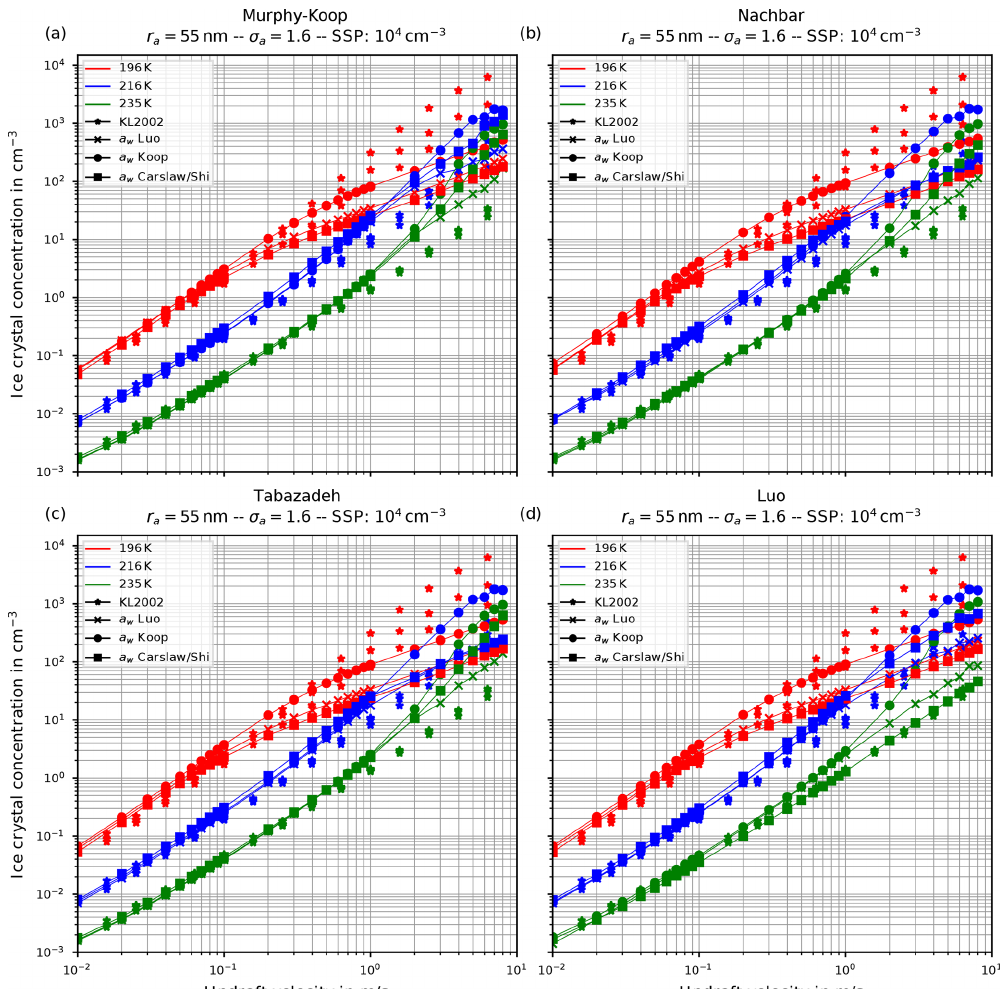
Figure 7. The same as in Fig. 6 but with the choice σ a = 1 . 6 for the dry aerosol lognormal size distribution.